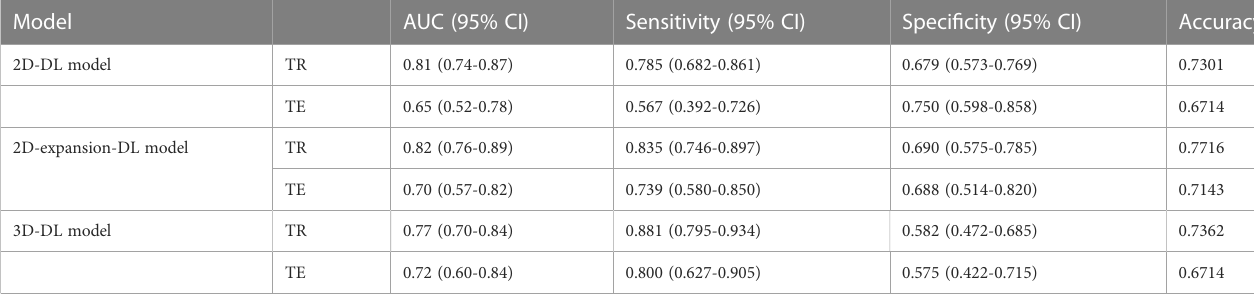
TABLE 2 Performance of different DL models in the training and the testing